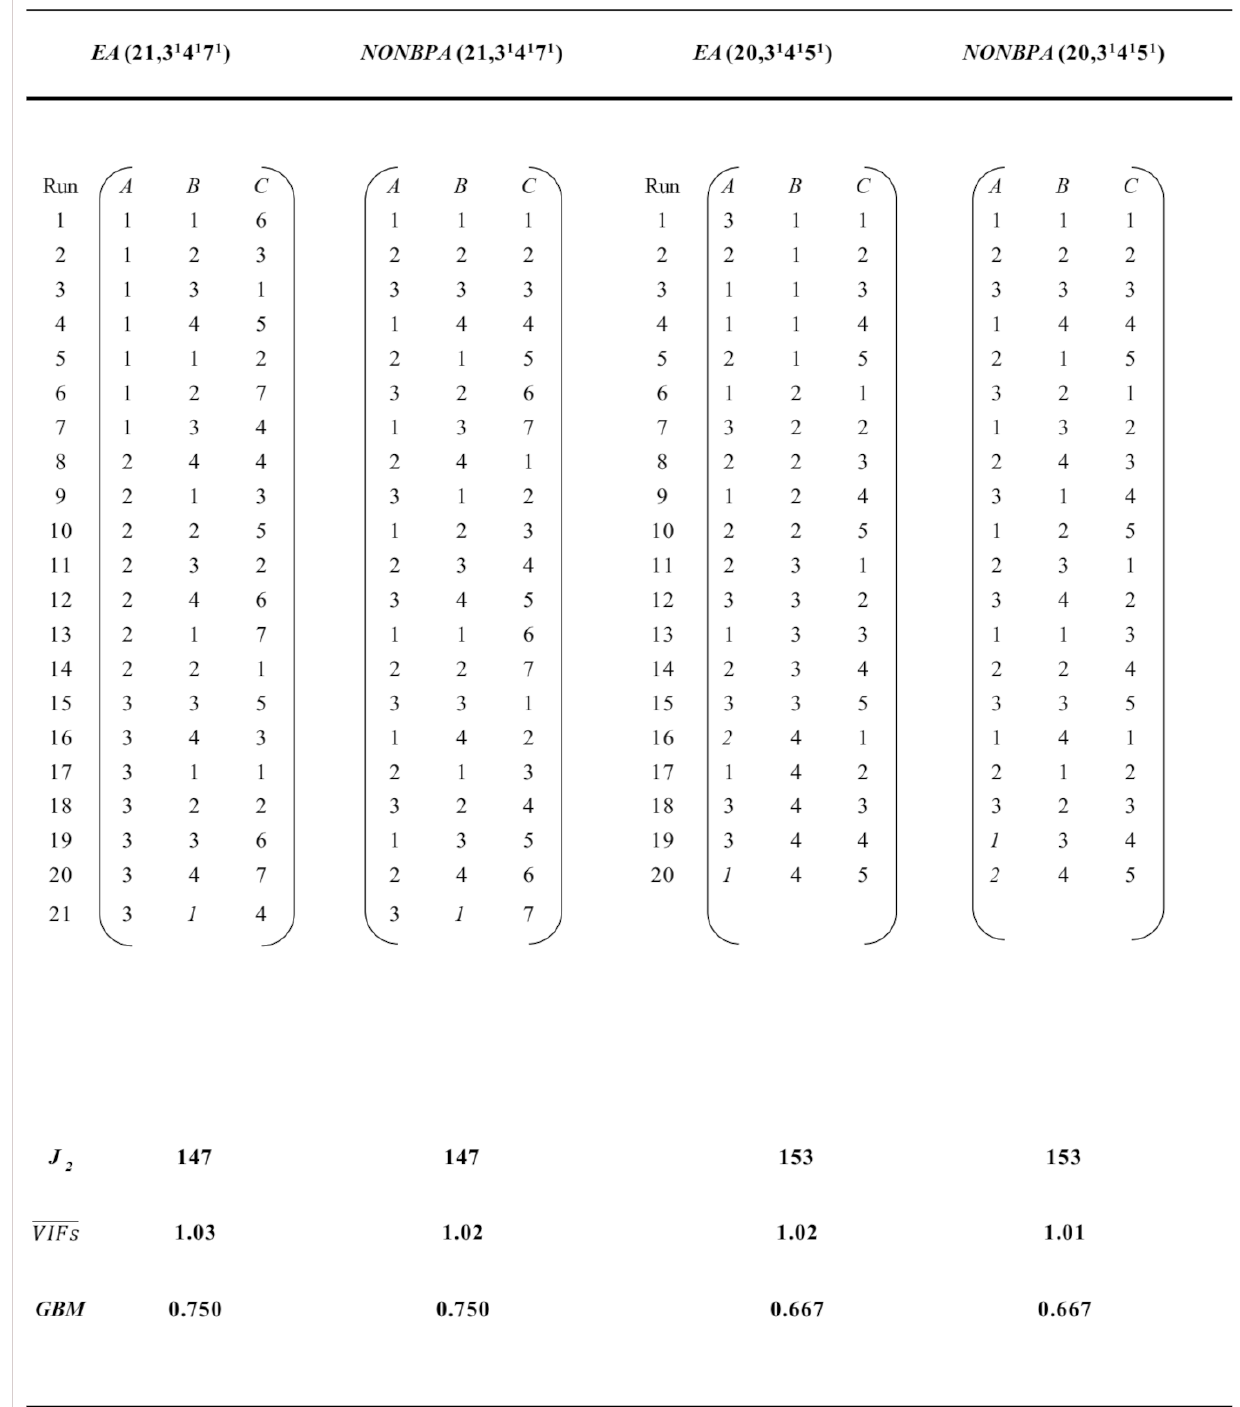
Figure 8. Comparison of EAs vs. NONBPAs for the (21,3 1 4 1 7 1 ) and (20,3 1 4 1 5 1